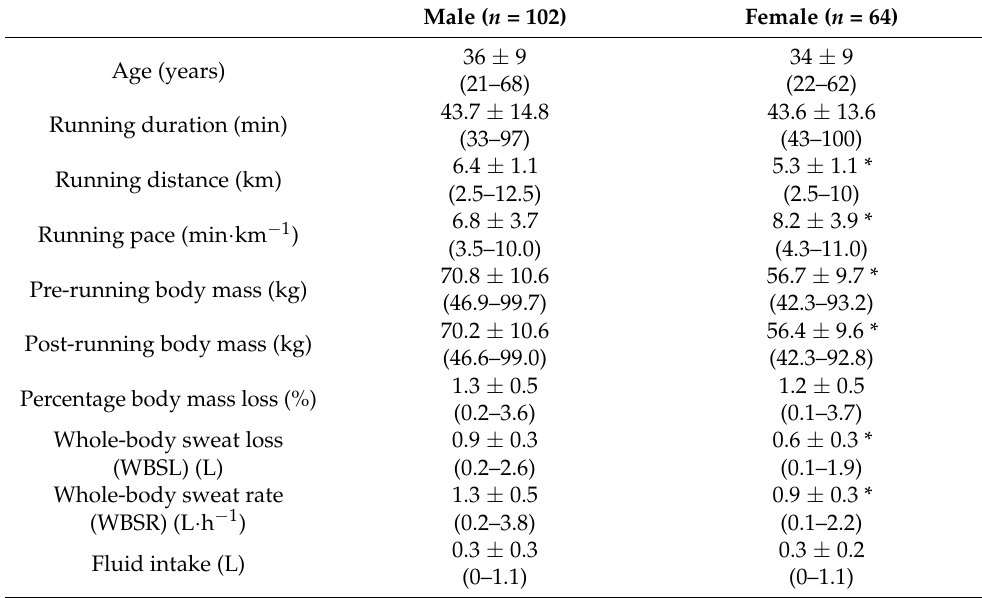
Table 2. Mean age, running profile, body mass change, sweat rate, and fluid intake of male and female runners across all running sessions. Data are presented as mean ± SD (range).